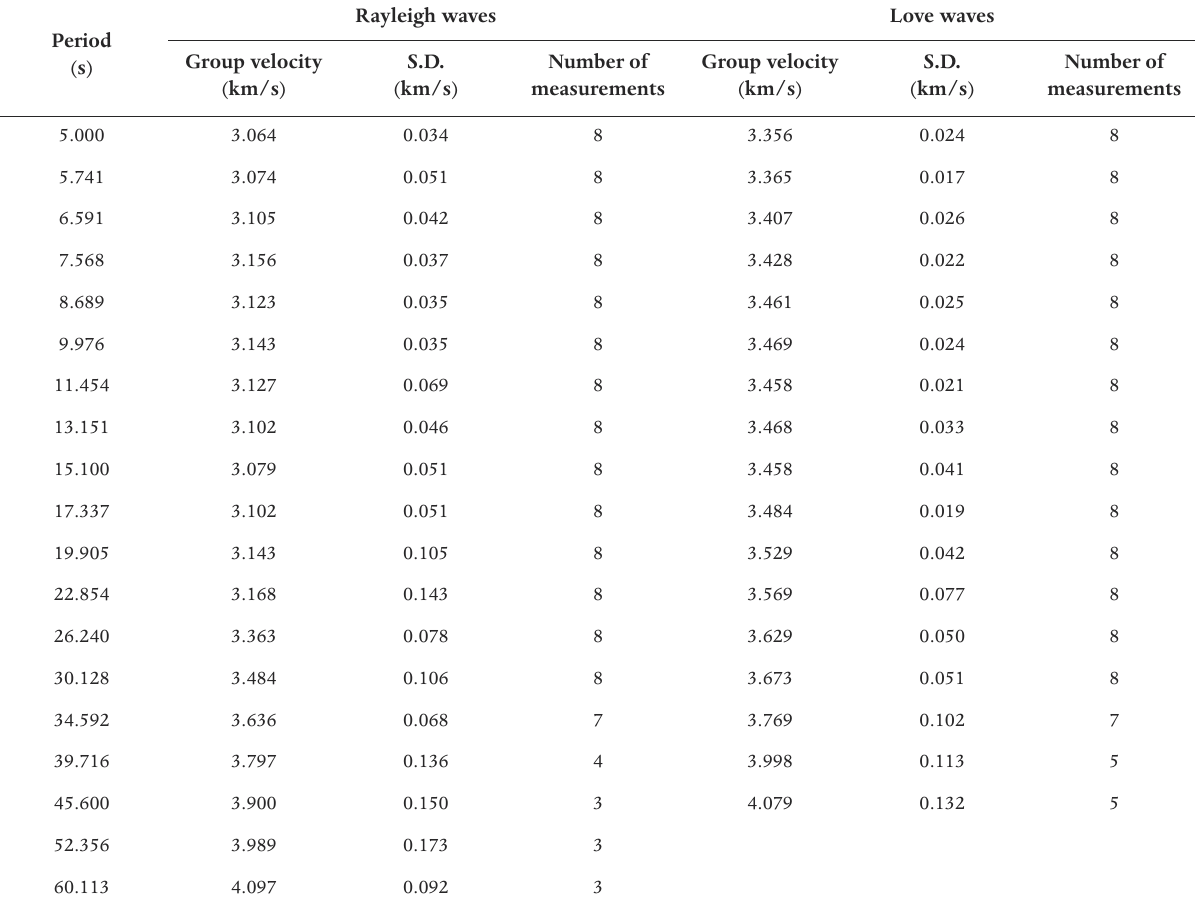
Table 2. Observed group velocities across central